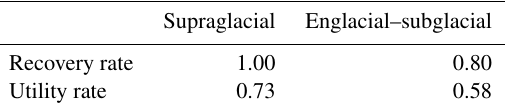
Table 1. Recovery and utility rates for supraglacial as well as englacial–subglacial deployments. The results from the supraglacial system are from the second experiment with five drifters and a to- tal of 55 deployments in the 450m long supraglacial channel sec- tion. Subglacial–englacial system rates are based on the assumption that the drifters can pass through the system, if the dummies pass through. The estimated total utility rate for subglacial–englacial de- ployments is based on the dummy deployment, as well as the data usability rate.